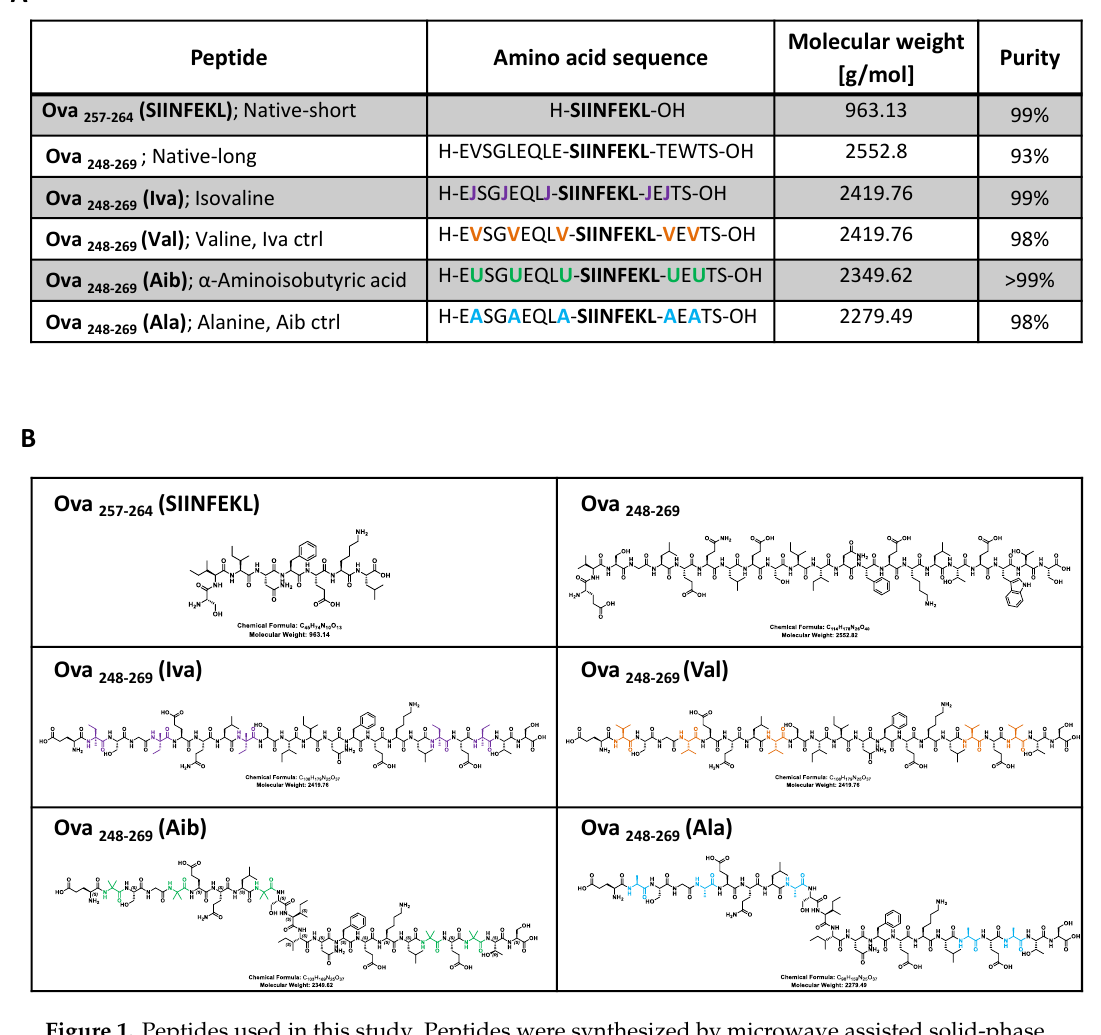
Figure 1. Peptides used in this study. Peptides were synthesized by microwave assisted solid-phase synthesisusingaCEMLibertyBluepeptidesynthesiser. ( A )CrudepeptideswerepurifiedbyPreparative HPLC (Supplementary Figure S1), identity and purity was evaluated by HPLC-MS (Supplementary Figure S2). Peptides synthesised used in this study based on ovalbumin (Ova), the main protein in egg white widely used as an antigen for immunization research. The specific amino acid residues Ova 257-264 (SIINFEKL) represent a T cell-dependent antigen used as a model peptide epitope for studying antigen-specific immune responses in mice. The position of amino acid exchange within the ova peptide, encompassing the core-SIINFEKL, is indicated by coloration; ( B ) the chemical structure of the synthesised peptide chains. The colored amino acids match the color code in A showing the position of the amino acids within the peptide